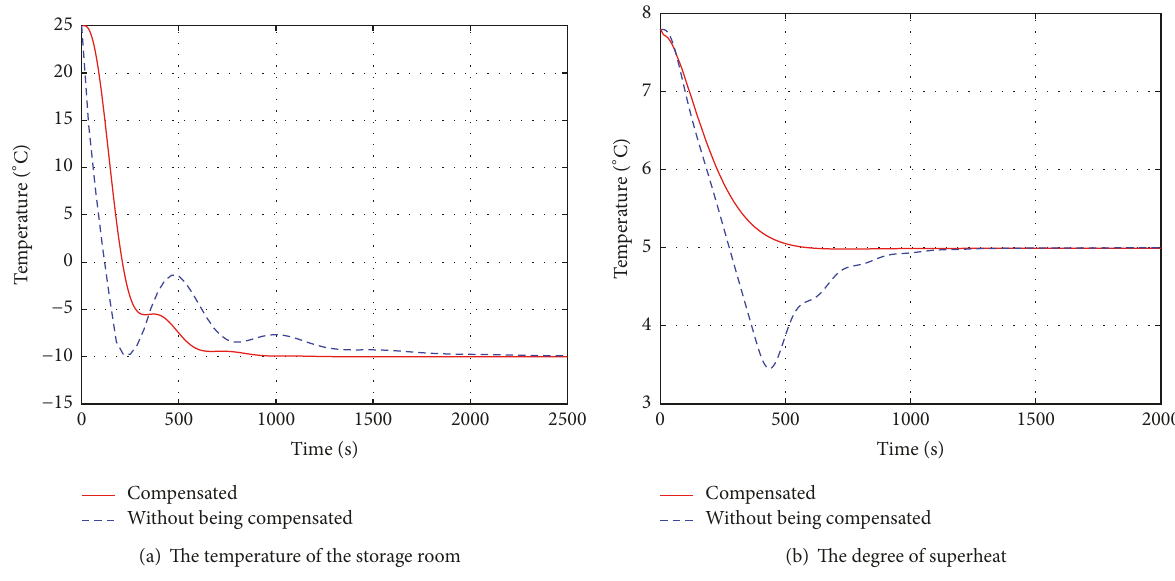
Figure 3: Response curves after the system